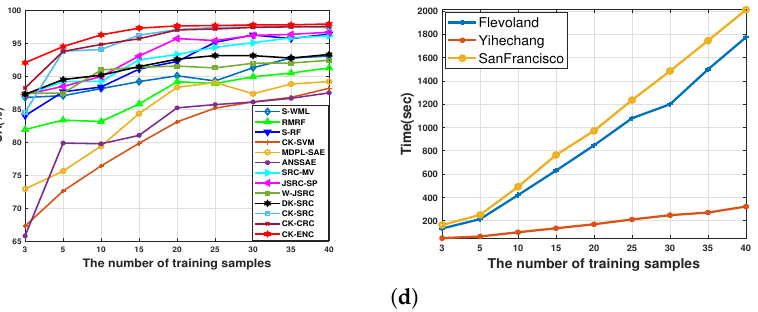
Figure 14. Effect of the number of training samples for ( a ) Flevoland dataset, ( b ) Yihechang dataset, and ( c ) San Francisco dataset. ( d ) Execution time (in seconds) of CK-ENC under different numbers of training samples for the three PolSAR datasets.